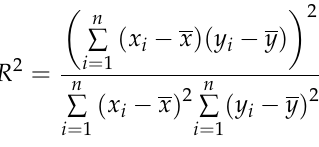
Figure 14. Contour plots of experimental data.